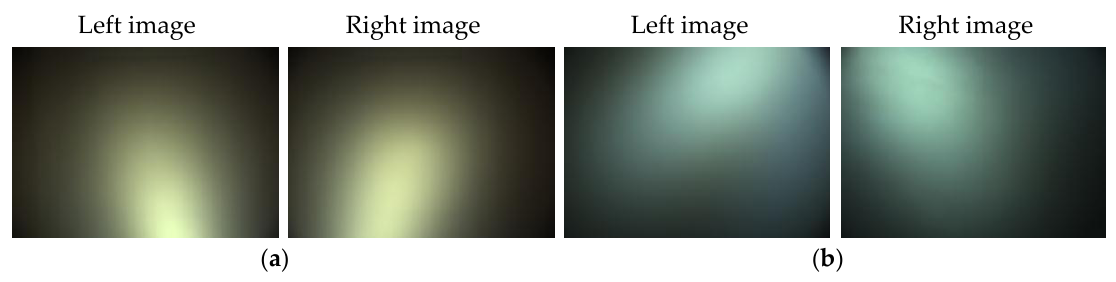
Figure 3. An example of saturated backscattering: ( a ) Lighting setup 1; ( b ) Lighting setup 2.